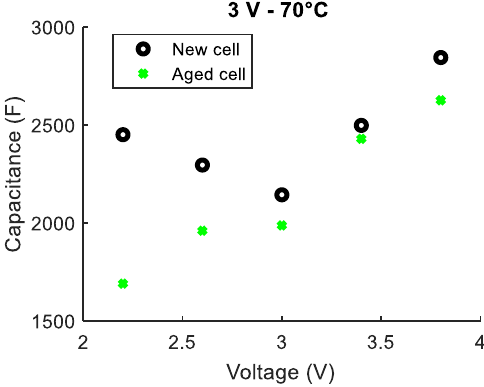
Figure 7. Comparison between the capacitances measured at 25 °C before and after aging for a LiC that aged at 3 V and 70 °C for 20 months.